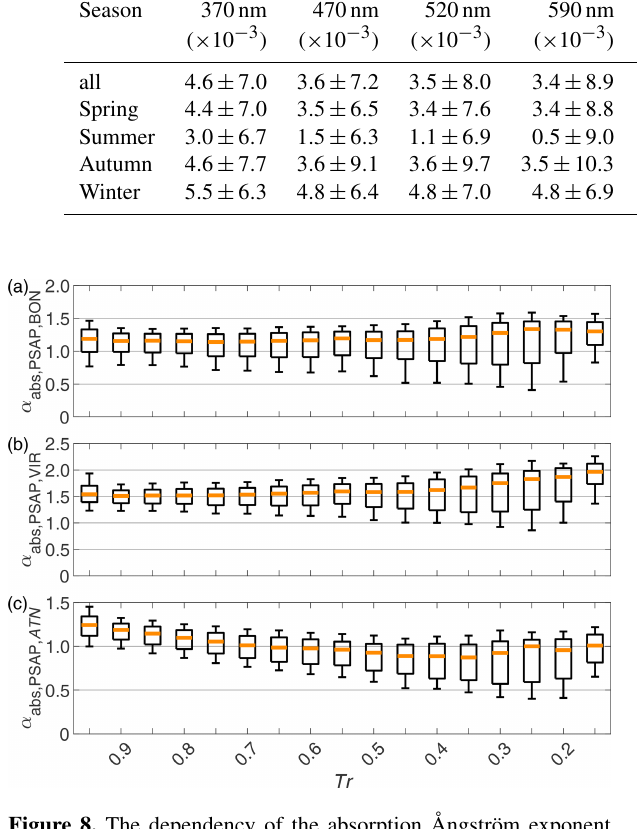
Figure 8. The dependency of the absorption Ångström exponent ( α abs ) on the PSAP filter transmittance (Tr) for (a) B1999, (b) V2010, and (c) non-corrected σ ATN . The explanation for the box- plots is the same as in Fig.